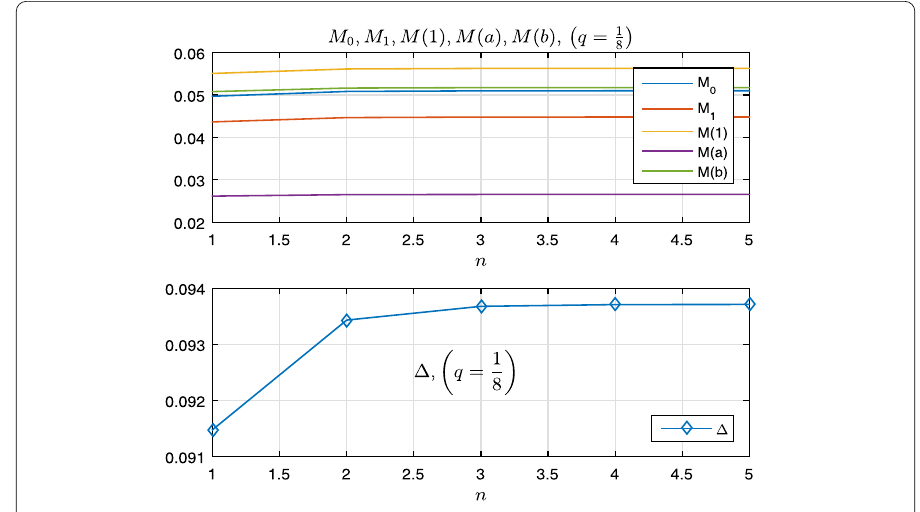
Figure 4 2D graphs M 0 , M 1 , M (1), M ( b ), M ( t ) on t ∈ J for q = 1